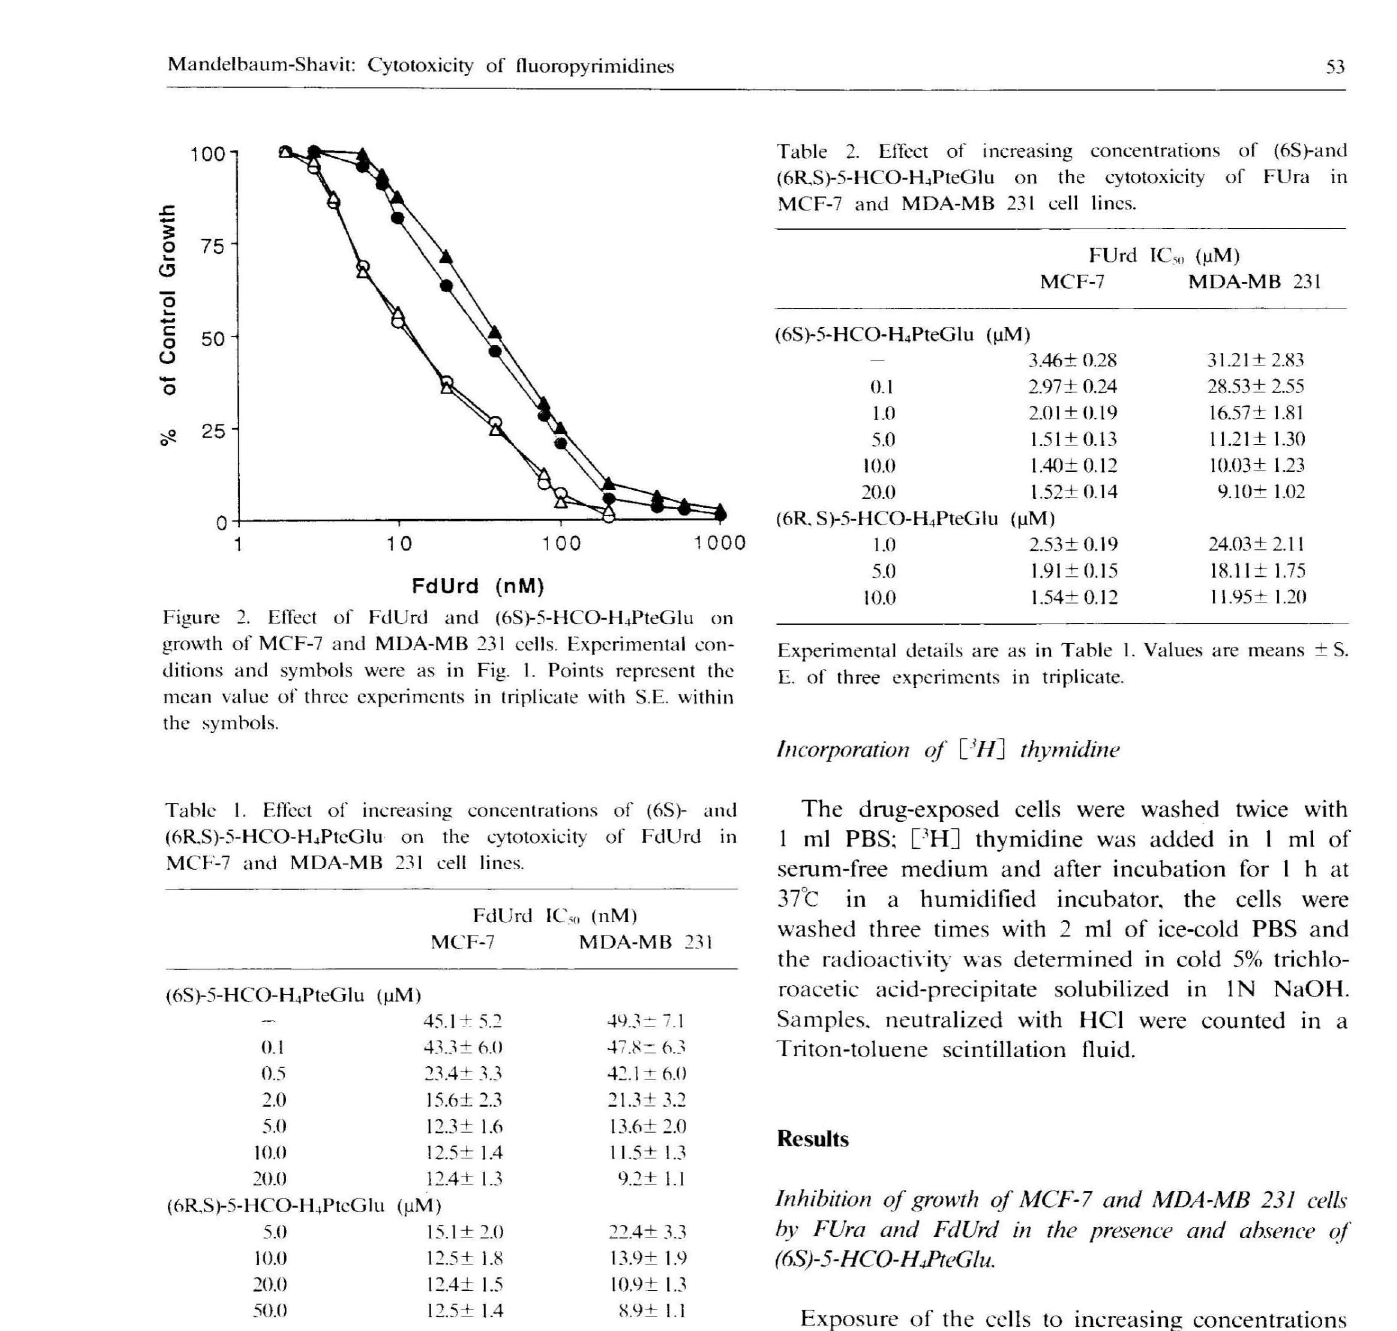
Table 2. EITeet of increasing concentrations of (6S)-and (6RS)-S-HCO-H 4 PteGlu on the cytotoxicity of FUra in MCF-7 and MDA-MB 231 cell